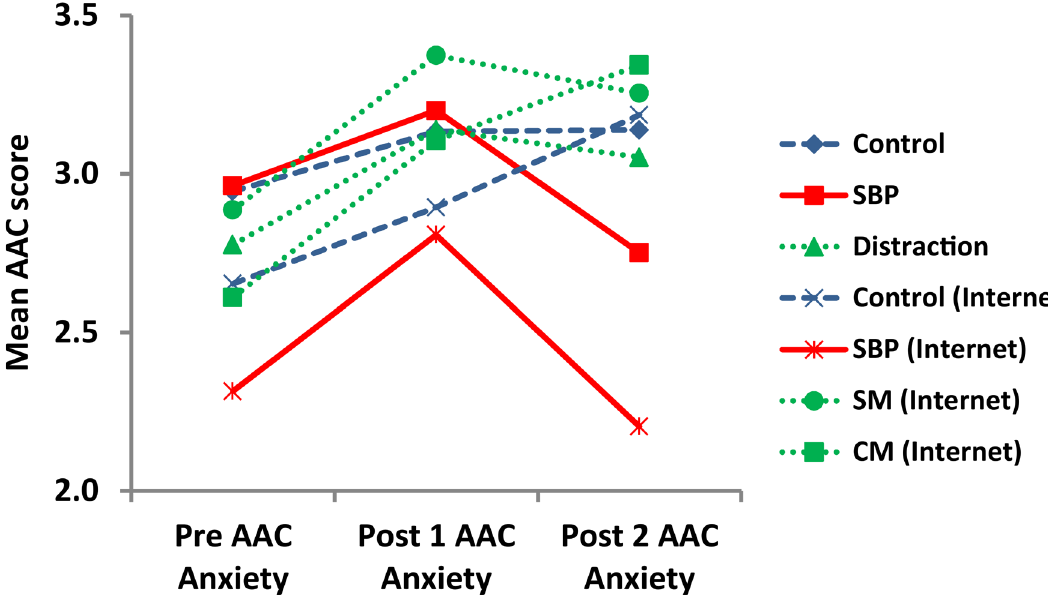
Fig 3. Mean scores for the Anxiety AAC composite between experimental groups. SBP: Secure Base Prime, SM: ” Smiling Man ” , CM: ” Cold Mother and Child ” .